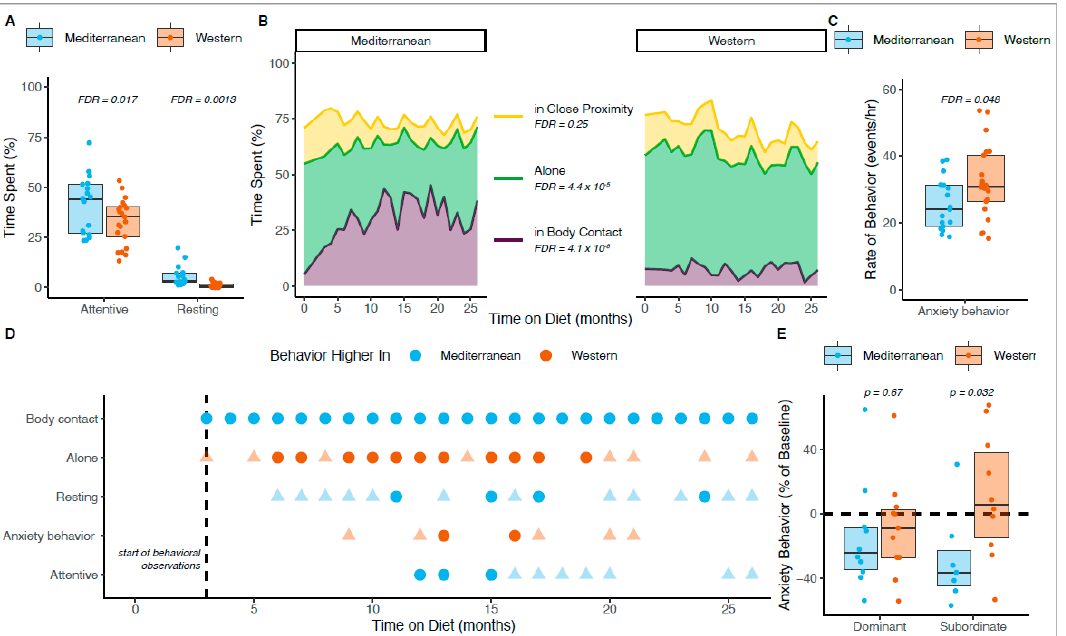
Figure 2. Changes in behavior following experimental diet treatments. ( A ) Monkeys in the Mediterranean group (blue boxes and points) spent more time attentive (ANCOVA F [1,35] = 8.6, FDR = 0.017) and resting (AVOVA F [1,36] = 15.6, FDR = 0.0013) than those in the Western group (orange boxes and points). ( B ) The left plot shows how monkeys in the Mediterranean group spent time in proximity to one another, while the right plot shows the same for monkeys in the Western group. Monkeys in the Mediterranean group spent more time in body contact (ANCOVA F [1,35] = 60.8, FDR = 4.1 × 10 − 8 ; purple) and less time alone (ANCOVA F [1,35] = 27.4, FDR = 4.4 × 10 − 5 ; green) than the Western group, while there was no significant difference in time spent in close proximity (ANCOVA F [1,35] = 0.8, FDR = 0.25; yellow). ( C ) The rate of anxiety behaviors observed in the Western group was significantly higher than in the Mediterranean group during the treatment phase (ANCOVA F [1,35] = 5.9, FDR = 0.048). ( D ) Points indicate months in which there was a significant difference between diet groups for a particular behavior. Circular points are significant after correcting for the multiple hypothesis test, whereas triangular points are those that do not pass the heightened threshold. Blue (Mediterranean) or orange (Western) points indicate which group displayed more of the behavior for that month. ( E ) Dominant monkeys in both diet groups decreased anxiety from baseline (left), although there was no significant difference in change in anxiety between diet groups (t (18.3) = 0.67). Only subordinates fed the Mediterranean diet decreased from baseline (right). Within subordinate animals, anxiety decreased significantly more in the Mediterranean group than in the Western group (t (14.9) = 2.37, p =